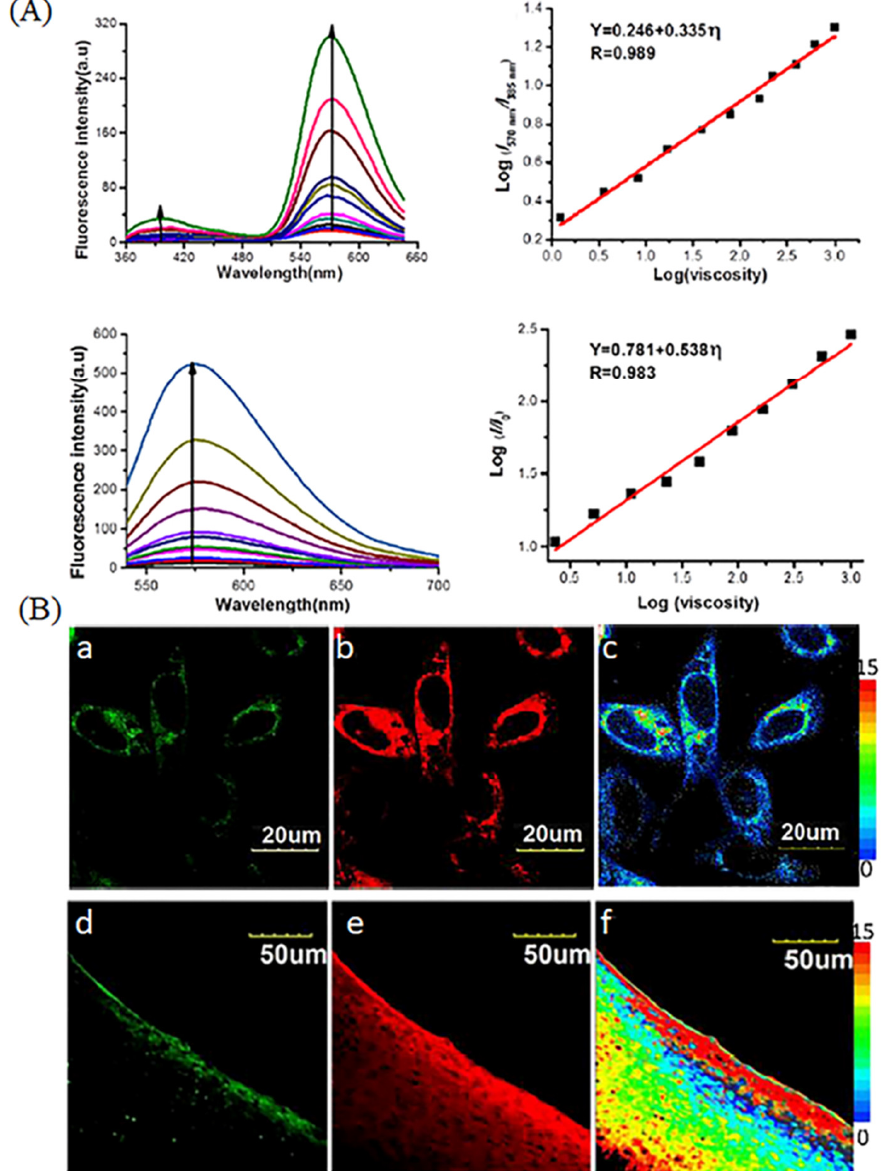
Figure 5. ( A ) Fluorescence changes and the linear response in the spectra of Qca-Cy2 in the solvent viscosity. ( B ) Fluorescence images of Qca-Cy2 in living HeLa cells and rat hepar slice in two channels. ( a , d ): green channel picture; ( b , e ): red channel pictures; ( c , f ): ratio pictures of ( a ) and ( b ); ( a – c ): confocal pictures of HeLa cells; ( d – f ): confocal pictures of rat hepar slice. Reproduced from Ref. [46] with permission of the Elsevier, copyright 2018.